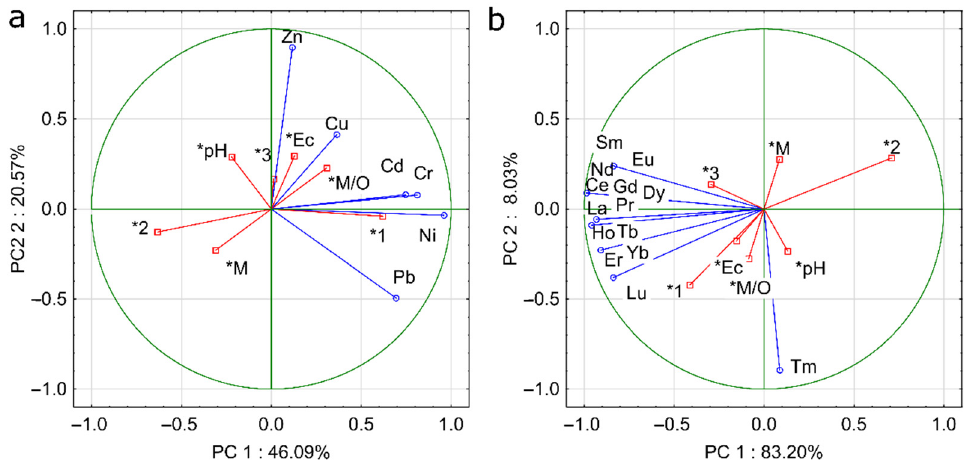
Figure 6. Results of PCA analysis for ( a ) HMs and ( b ) REEs (M/O, mineral/organic sediments; M, mineral sediments, pH value; EC, electric conductivity; 1, site located 50 m upstream of discharge, 2, site 100 m downstream of discharge; 3, site 1 km downstream of discharge.